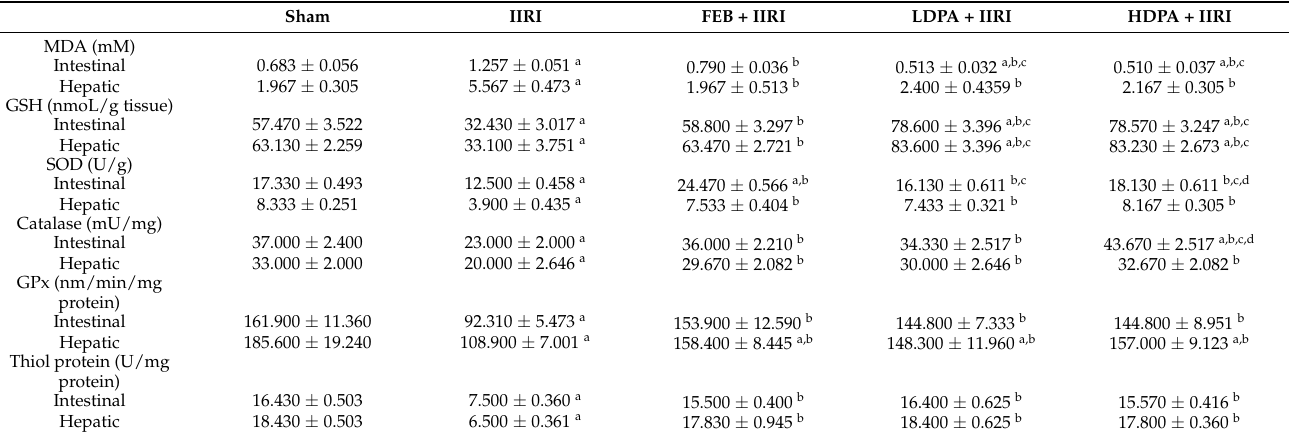
Table 4. Effect of intestinal ischemia/reperfusion (I/R) and methanolic Phyllanthus amarus leaf extract on oxidative stress markers and antioxidants.